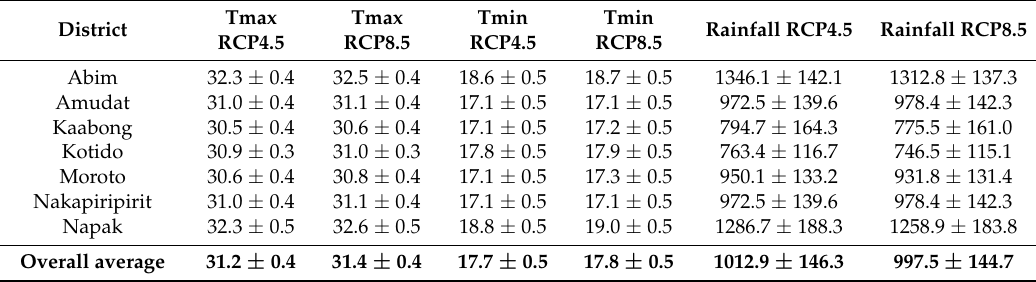
Figure 4. Historical trend of maximum temperature in Karamoja sub-region. Table 3. Summary of maximum and minimum temperature and Rainfall under RCP4.5 and RCP8.5 in the Near